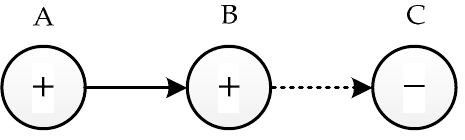
Figure 3. A simple SDG model structure.